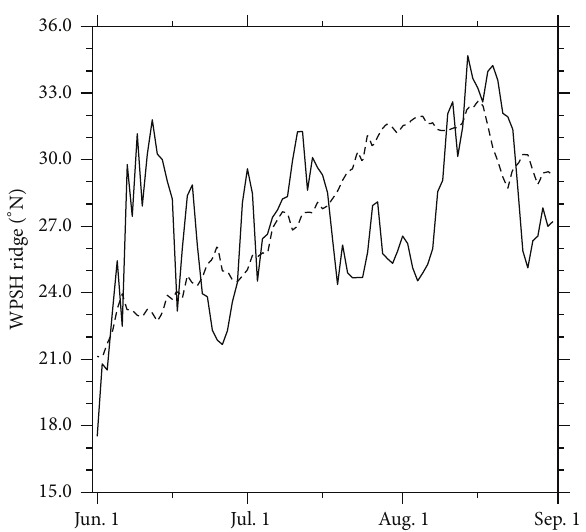
Figure 4: The variation of the climatic position (dashed line) and the position in the summer of 2013 (solid line) for WPSH ridge line at 500 hPa.